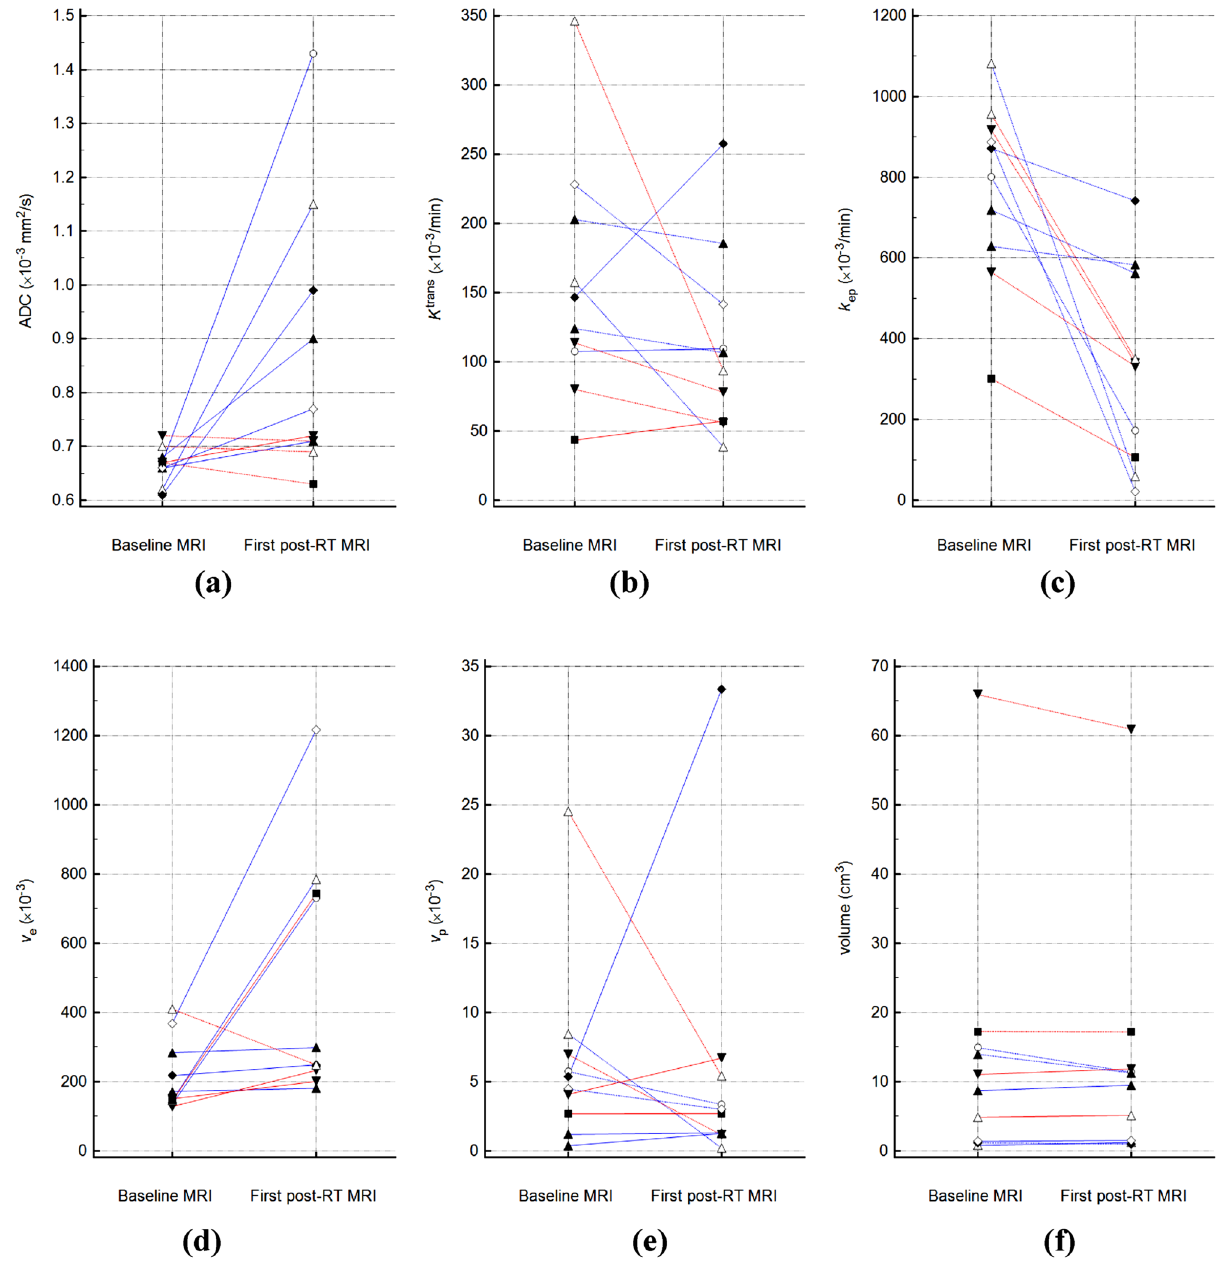
Figure 3. Graphs showing changes in ( a ) ADC, ( b ) K trans , ( c ) k ep , ( d ) v e , ( e ) v p , and ( f ) tumor volume following RT for each patient. The increasing values are represented by solid lines and the decreasing ones by dashed lines. The data of the non-PD and PD groups are represented by blue and red lines, respectively. ADC, apparent diffusion coefficient; K trans , volume transfer constant; k ep , rate constant; PD, progressive disease; RT, radiation therapy; v e , volume fraction of the extravascular extracellular matrix; and v p , blood plasma